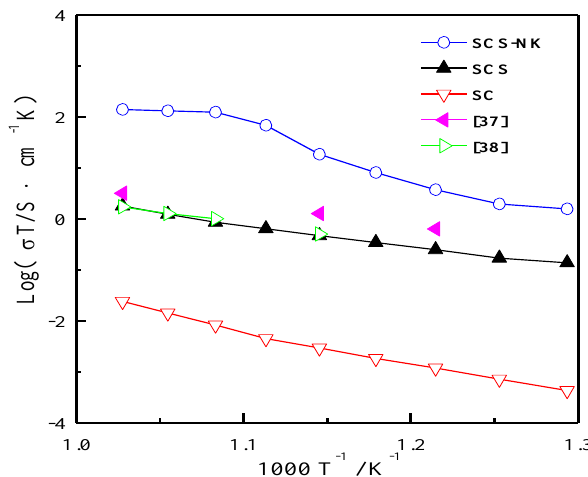
Figure 4. Temperature dependence of the conductivities of SrCeO 3 (SC), SrCe 0.9 Sm 0.1 O 3-α (SCS) and SrCe 0.9 Sm 0.1 O 3-α -NaCl-KCl (SCS-NK) in dry nitrogen atmosphere at 500–700 °C.